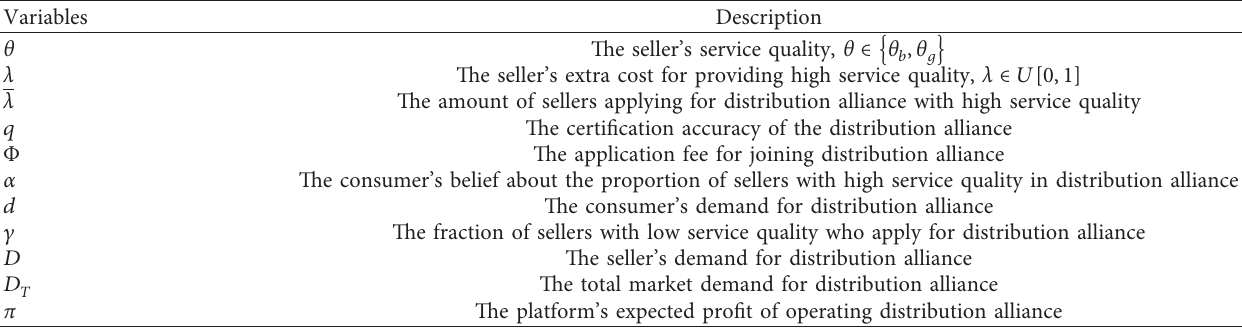
Table 1: Notations used in the